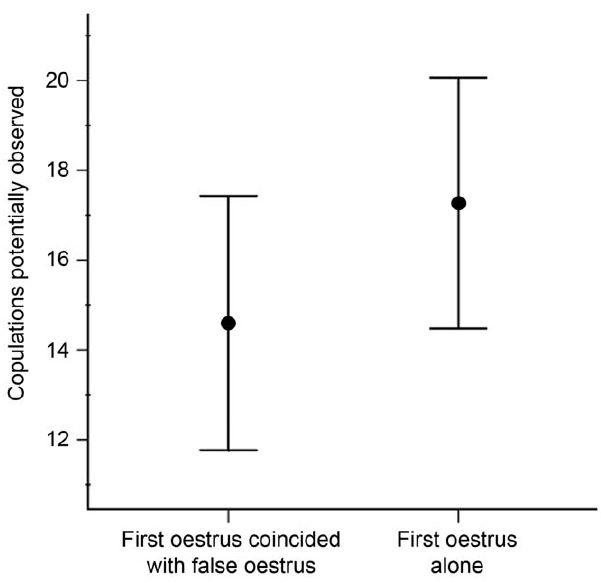
Figure 2. Number of within-family oestrus events observed by nulliparous females. The mean ( 6 2 SE) number of within-family oestrus events that nulliparous females could potentially have observed before their own first oestrus event, according to whether that first oestrus event coincided with a false oestrus event of a family member, or if it occurred alone. The number of oestrus events that were potentially observed is a minimum figure, collated from birth records and the oestrus